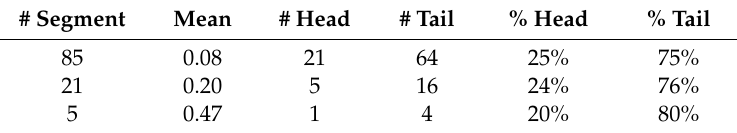
Table 4. Statistics of the head / tail breaks process for the Koch